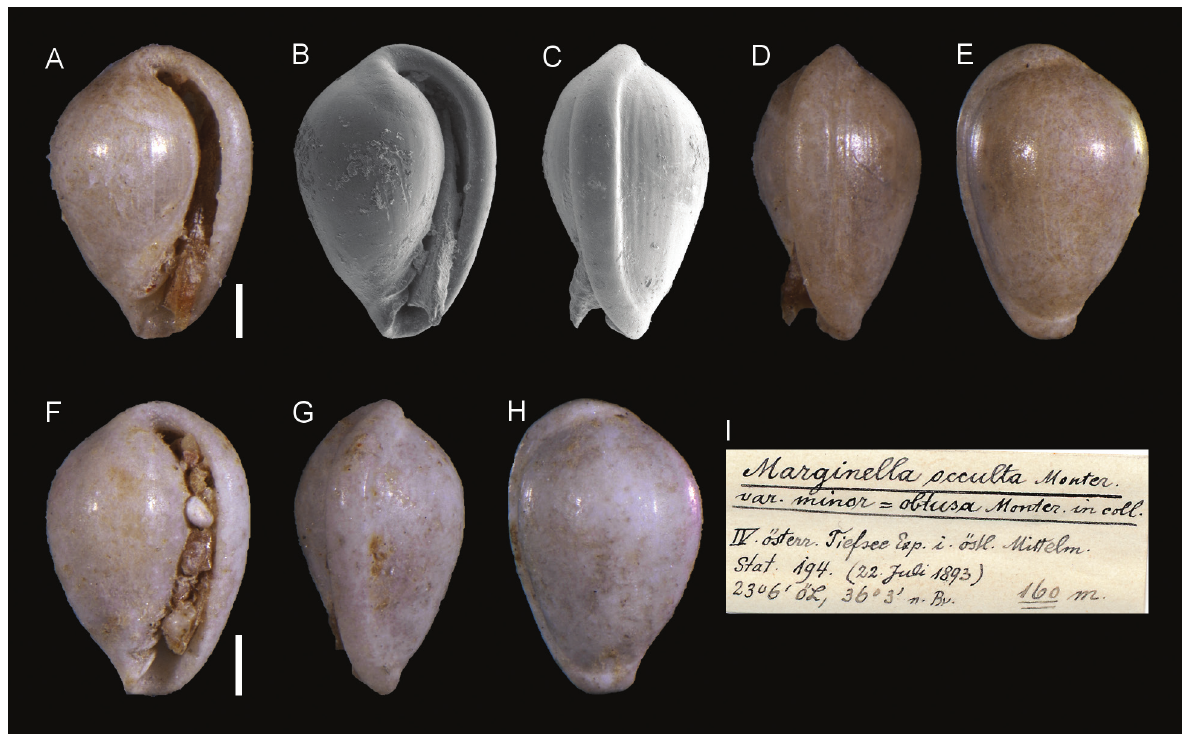
Figure 6. Marginella occulta var. minor Sturany, 1896, Station 194, between Kythira and Antikythira, Ionian Sea, Greece, 160 m. A–E . NHMW 13012: front ( A–B ), side ( C–D ) and back ( E ) views. F–H . NHMW 13012: front ( F ), side ( G ) and back ( H ) views. I . Original label. Scale bars: 0.5